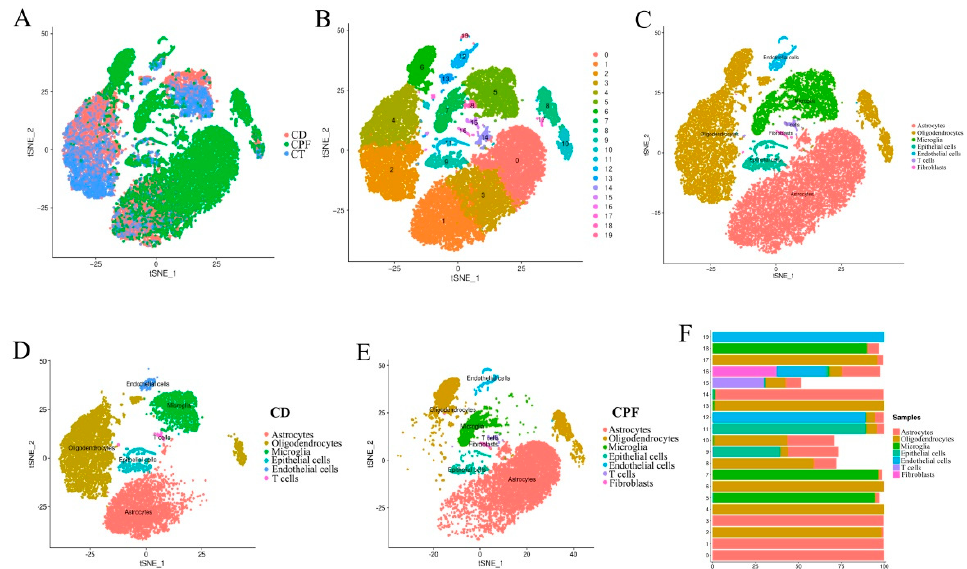
Figure 4. Single-cell RNA-seq identified circadian-rhythm-associated brain cell populations in the hypothalamus of mice: ( A ) t-SNE map of single cells of the hypothalamus in the CD, CT, and CPF groups. ( B ) t-SNE images of total hypothalamic cells in different clusters. ( C ) t-SNE identification map of hypothalamic single cells in the CT, CD, and CPF groups of samples. ( D ) t-SNE identification map of hypothalamic single cells in the CD group. ( E ) t-SNE identification map of hypothalamic single cells in the CPF group. ( F ) The percentage of cell types identified per cell cluster.